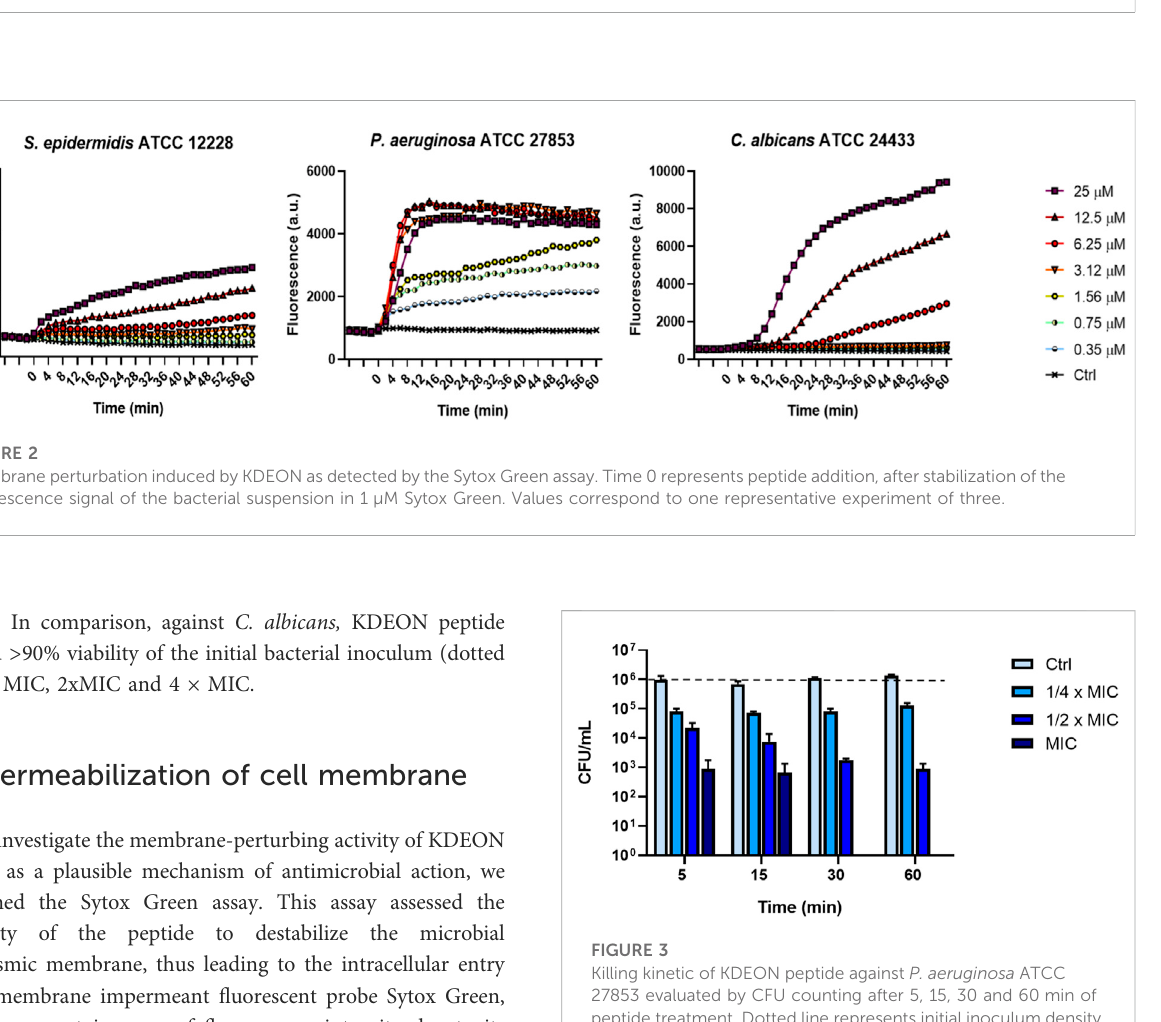
FIGURE 1 Bacterial cells viability expressed as CFU/mL after 18 h of peptide treatment. Dotted line represents initial inoculum density. Data represent the mean ± SEM of three independent experiments.